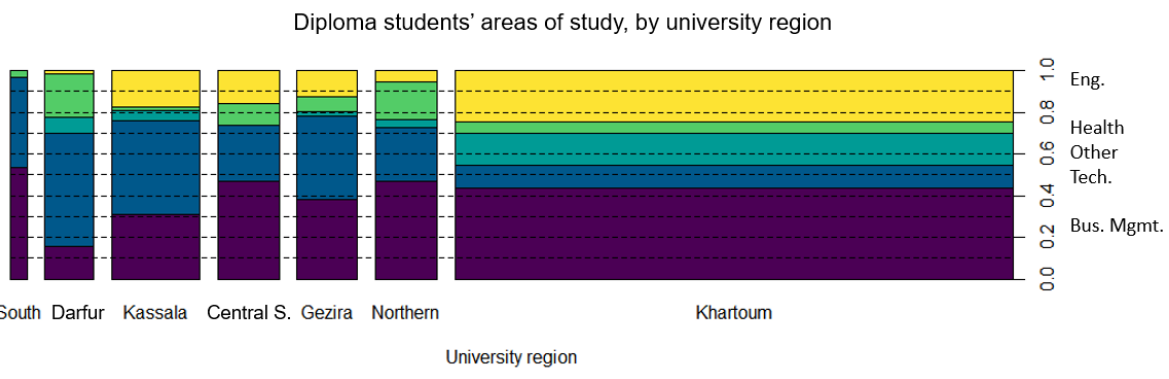
Figure 28. Spine plot departmental enrollments (by category) by sex for university region for diploma students